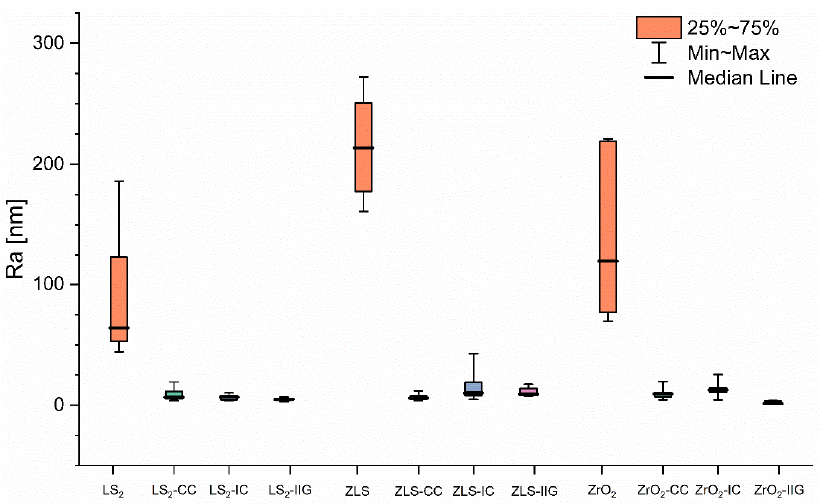
while MAX denoted the highest value.